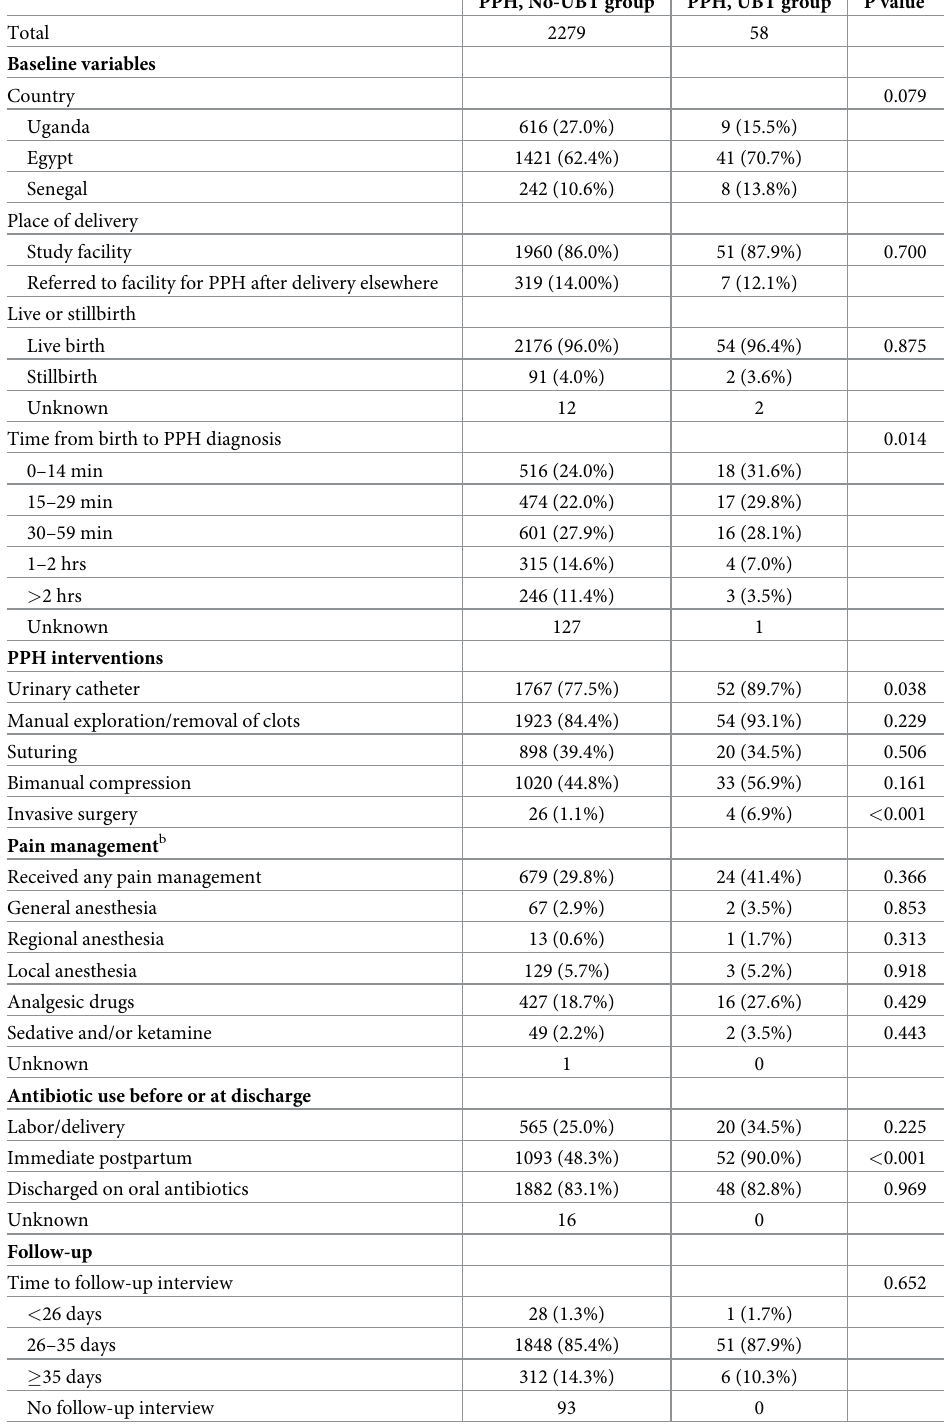
Table 1. Background characteristics of women diagnosed with PPH and included in the nested cohort